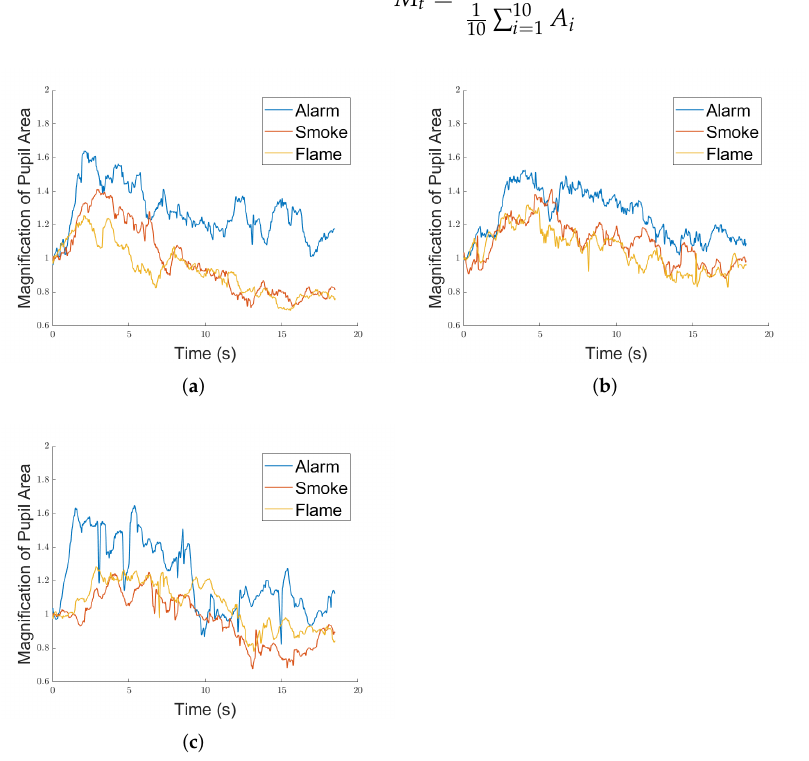
Figure 9. Three typical cases of pupil dilation. ( a ) Case 1, ( b ) Case 2, ( c ) Case 3.